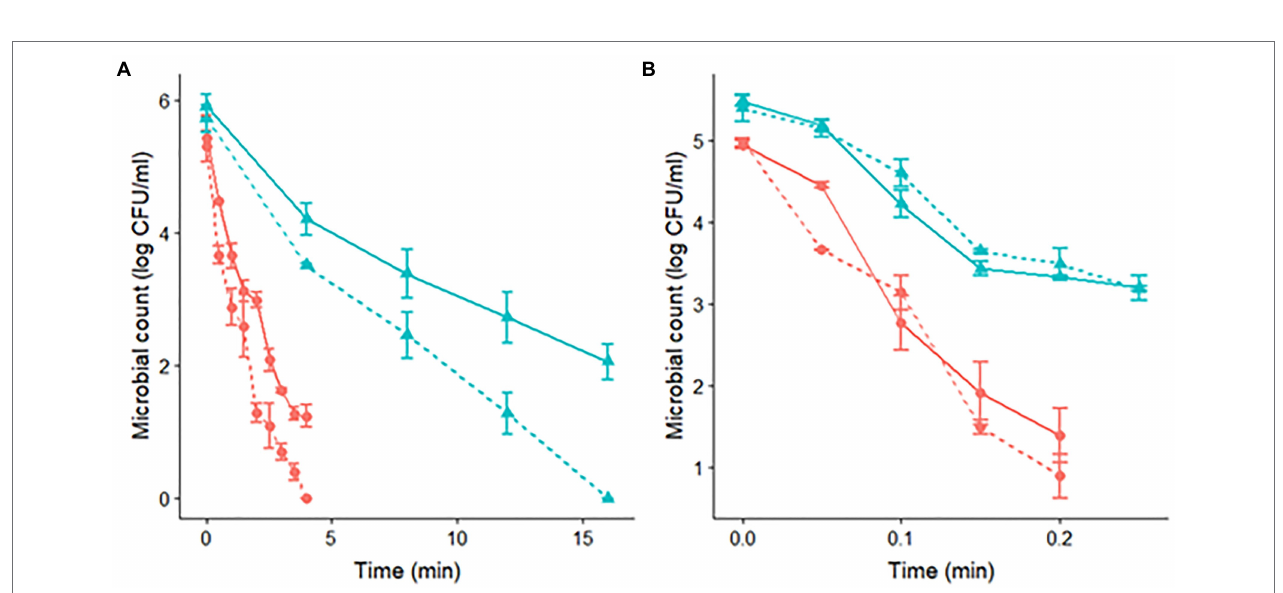
FIGURE 1 | Survivor curves of S. Senftenberg (A) and S. Enteritidis (B) during isothermal treatments at 60 ° C in peptone water. The pH of the heating media was set at pH 7.0 ( ) and pH 4.5 ( ). Experiments were made for cells with a previous acid shock (dashed lines) and control cells, without acid shock (continuous lines).